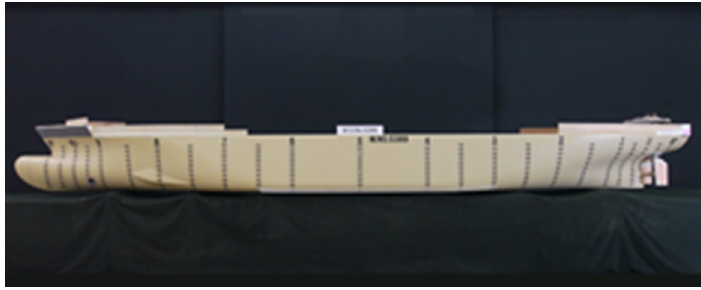
Figure 11. Large (6.18 m) ship model tested in 400 m towing tank. Table 4. Principal dimensions of ship and models.